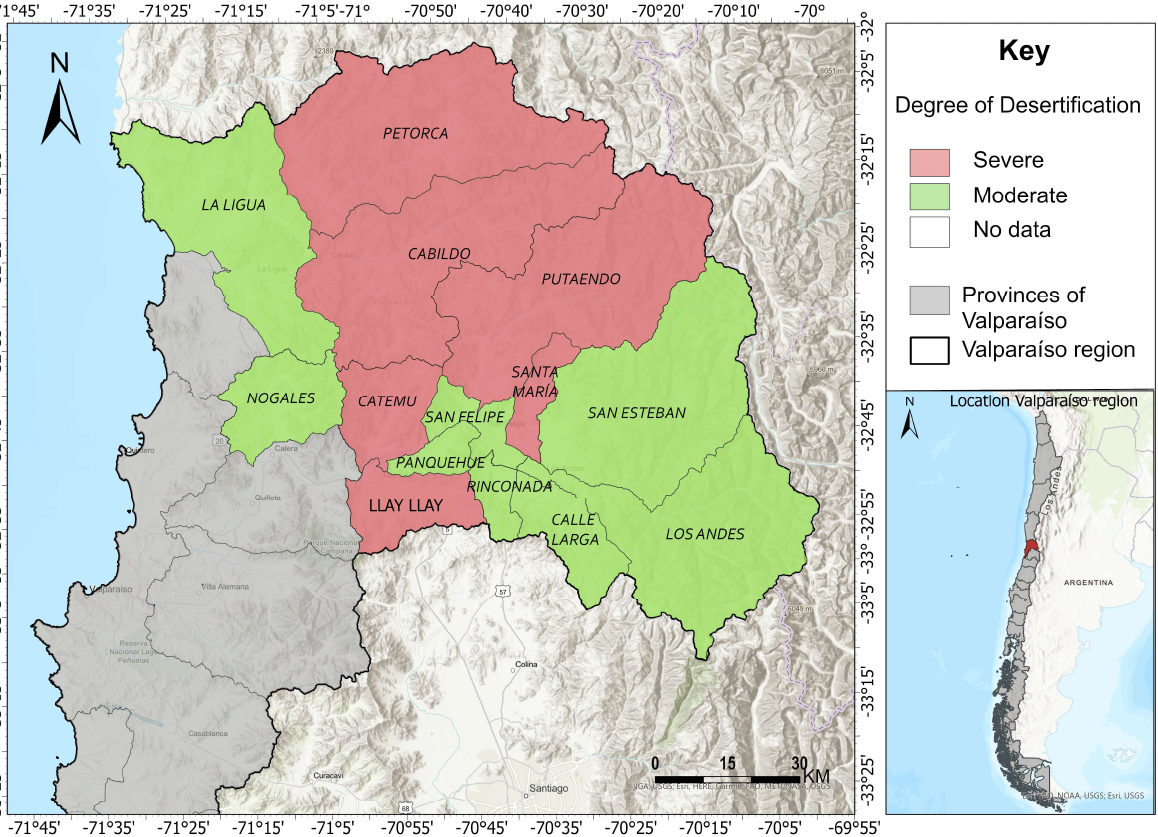
Figure 5. Degree of desertification of the study area.